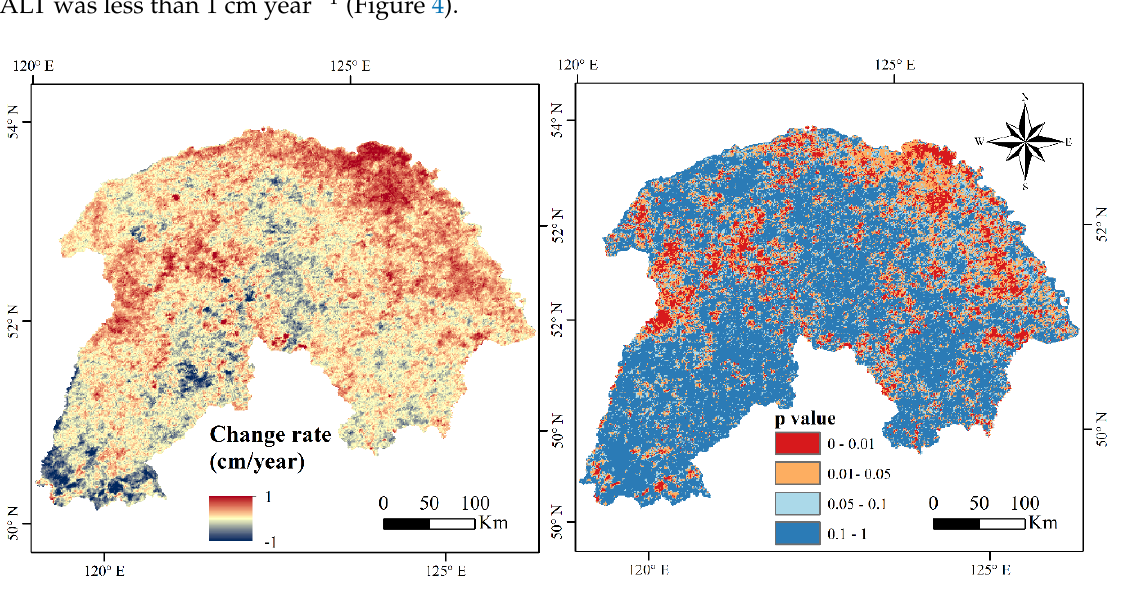
Figure 4. The Mann–Kendall Sen’s slope of the four-year moving averaged active layer thickness (m year −1 ) and the corresponding confidences ( p values) of the change trend from 2000 to 2015 in the study area.